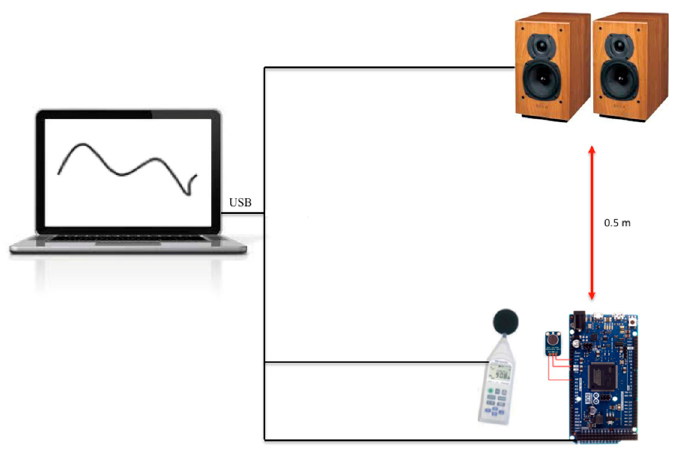
Figure 5. The scenario for indoor measurement tests.